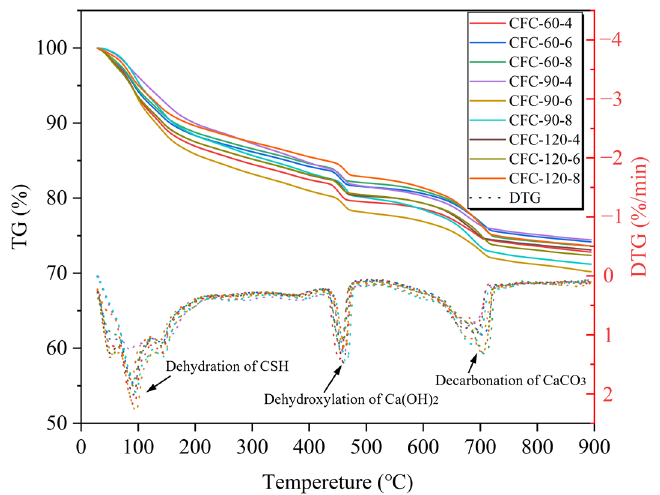
Figure 7. TG-DTG of PC-CFC.